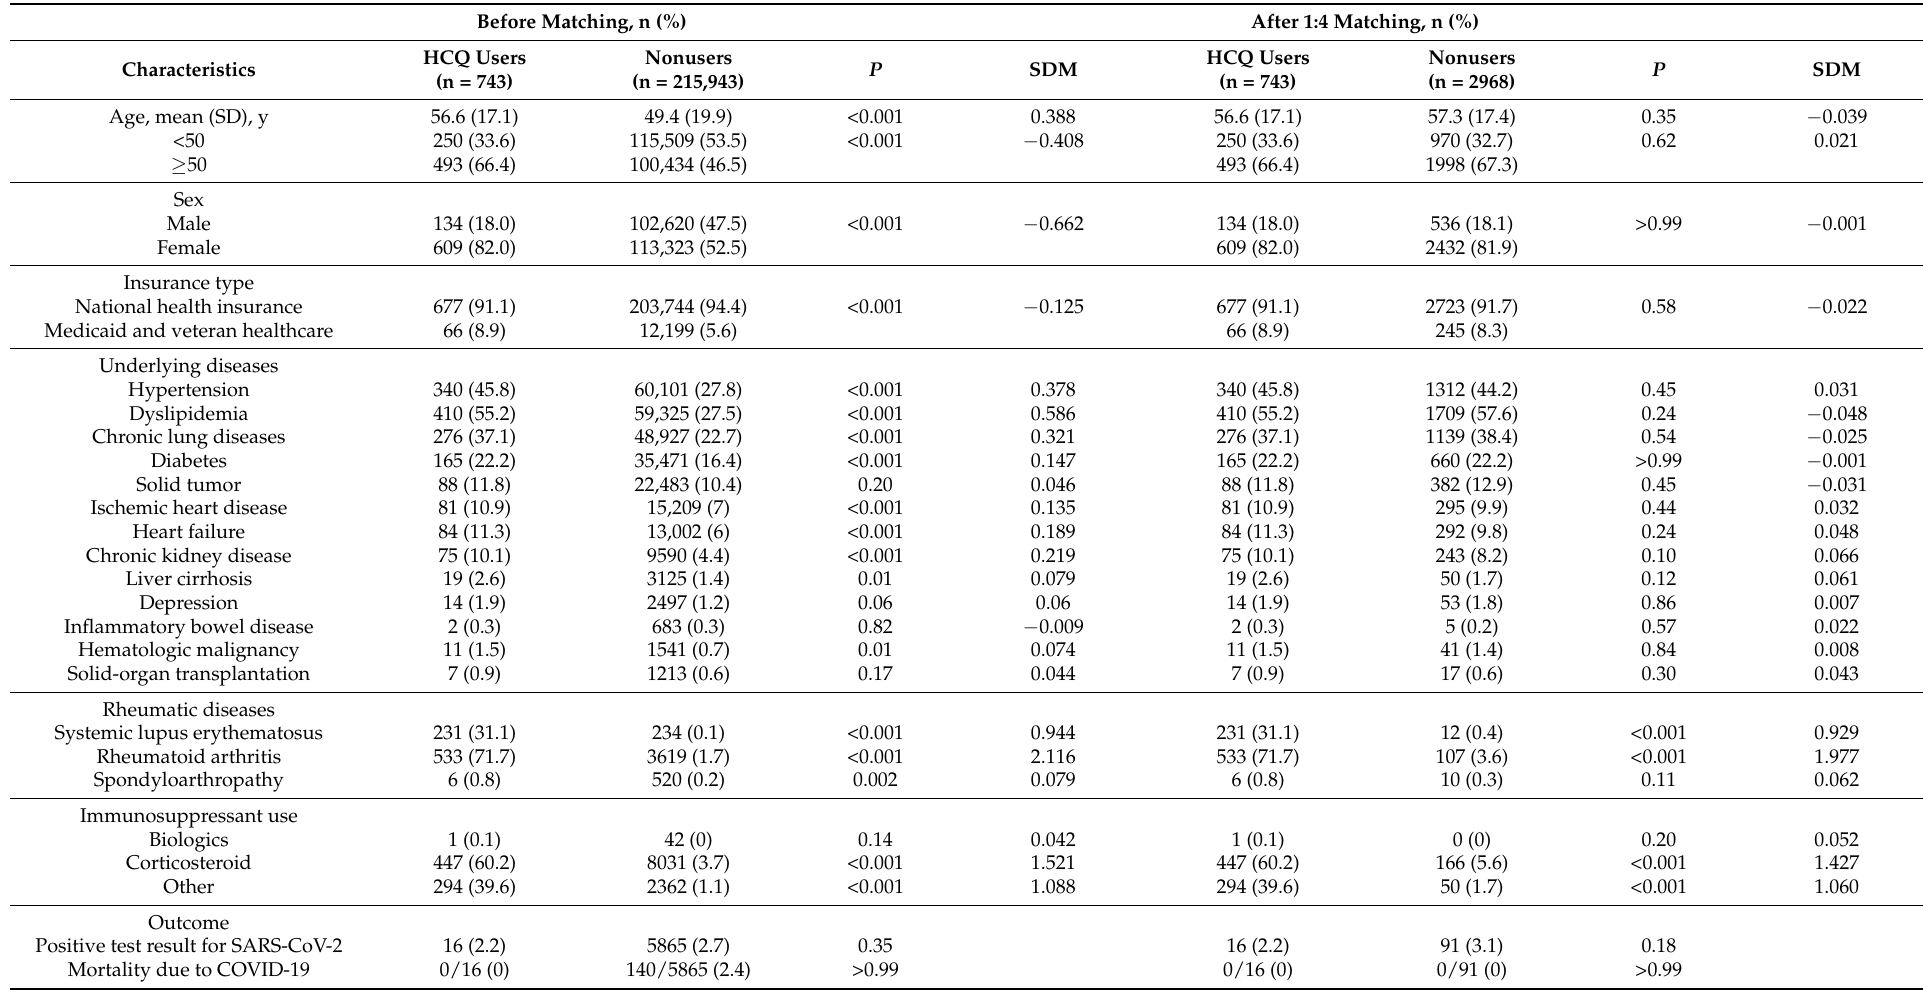
Table 2. Baseline demographic characteristics, prevalence of positive test results, and COVID-19 mortality of patients tested for SARS-CoV-2 according to hydroxychloroquine (HCQ) use. Before Matching, n (%) After 1:4 Matching, n (%)